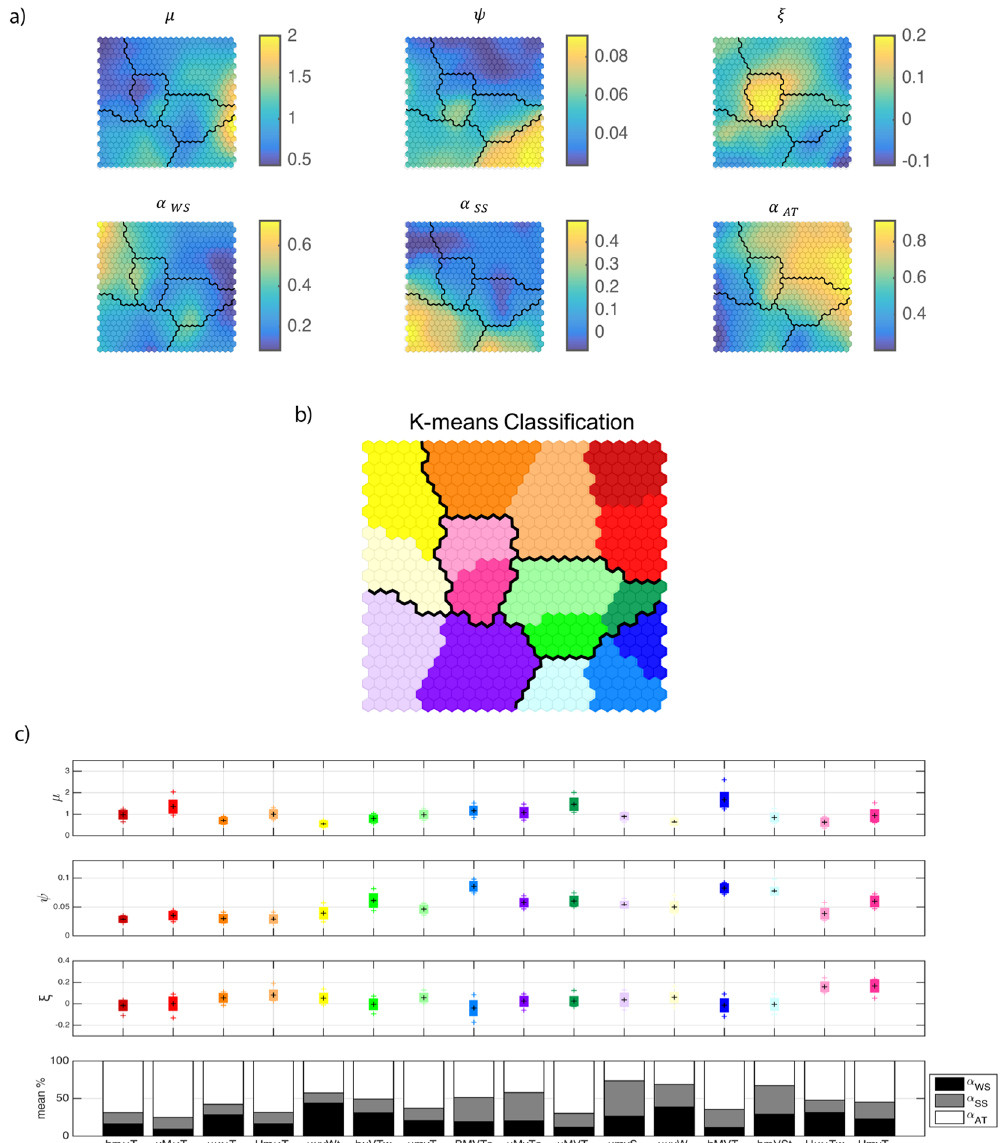
Figure 2. Clusters. ( a ) SOM classification; ( b ) K-Means classification in 16 groups; ( c ) Contribution of each (PDO) 34 . On the other hand, a remarkably different climate would be, for example, “uvWt”, namely the “lightly-unbounded micro-level medium-variable waves-tide-dominant” climate, which has the capital letter ‘W’ for the main contribution and a lower case letter “t” for the second contribution when it is larger than 36%. This climate is mainly characterized by the contribution of the waves and can be found in mid-low latitudes such as western Australia or eastern Madagascar. A benefit of the SOM/K-means classification algorithm is that closely related groups among the K = 16 clusters of flood hazard climates can be easily detected in the 2D SOM lattice in Fig. 2b. These groups, enclosed by thick black lines in Fig. 2-a and b, are defined as: a) TIDE-dominated ( α AT ≫ α SS, α WS) flood hazard climates (bm ω T, uM ω T, u µ ω T and Um ω T), which are located mainly between the tropics and and are colored in red scale. b) Tropical cyclone (TC) flood hazard climates (U µ ω Tw and UmVT) with ξ > 0, which are colored in pink. c) EXTRATROPICAL flood hazard climates (bMVT, BMVTs, bmVSt) with bounded flood levels ( ξ < 0) and large interannual variability (large ψ ), which are located mainly in the northern hemisphere and are color- ed in blue. d) WAVE-dominated ( α WS ≫ α AT, α SS) flood hazard climates (u μ vWt, u μ vW) colored in yellow.